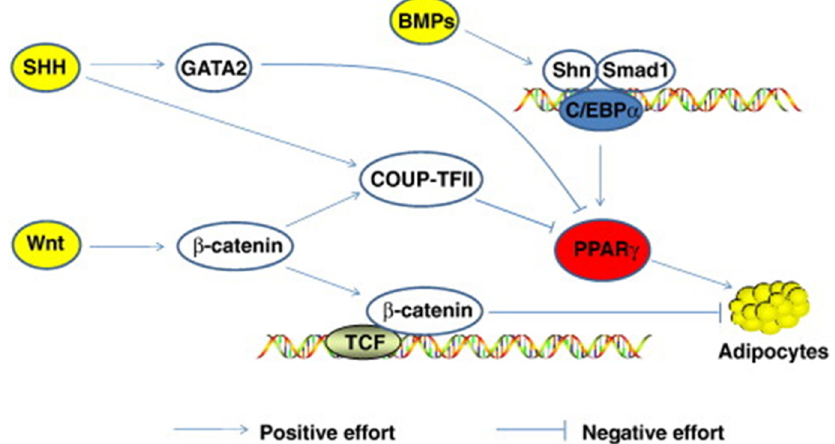
Figure 2. Mechanism for SHH and Wnt signaling. COUP-TFII binds to PPAR γ and C/EBP α to inhibit expression [23].